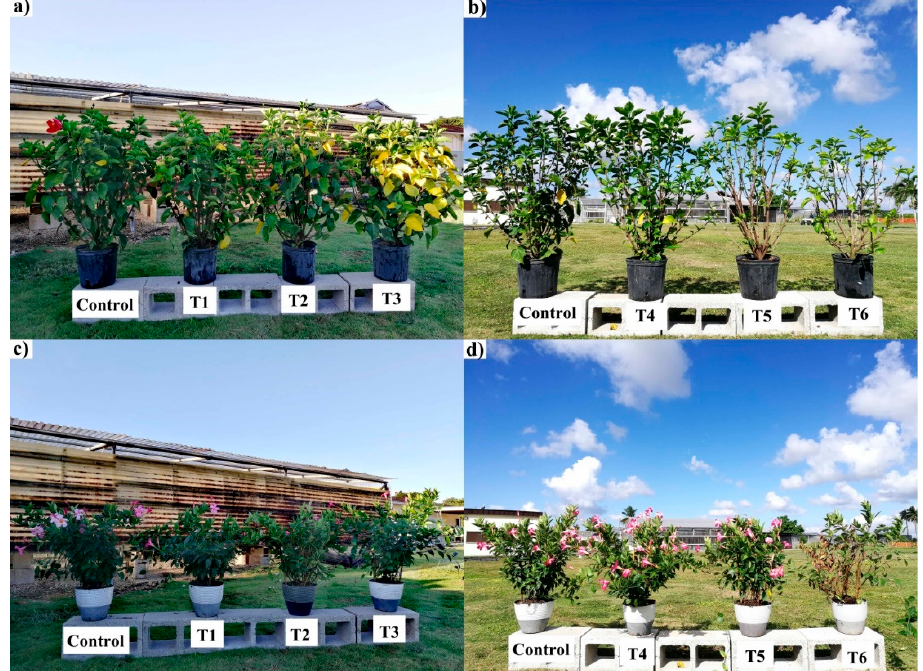
Figure 3. Visual comparison between plants treated with the different irrigation water salinity concentrations. ( a , b ) H. rosa ‐ sinensis ; ( c , d ) M. splendens ; ( a , c ) first experiment, Control: 0.5 dS/m, T1 1.0 dS/m, T2: 1.5 dS/m, T3: 2.0 dS/m; and ( b , d ) second experiment., Control: 0.5 dS/m, T4: 4.0 dS/m T5: 7.0 dS/m, T6: 10.0 dS/m.